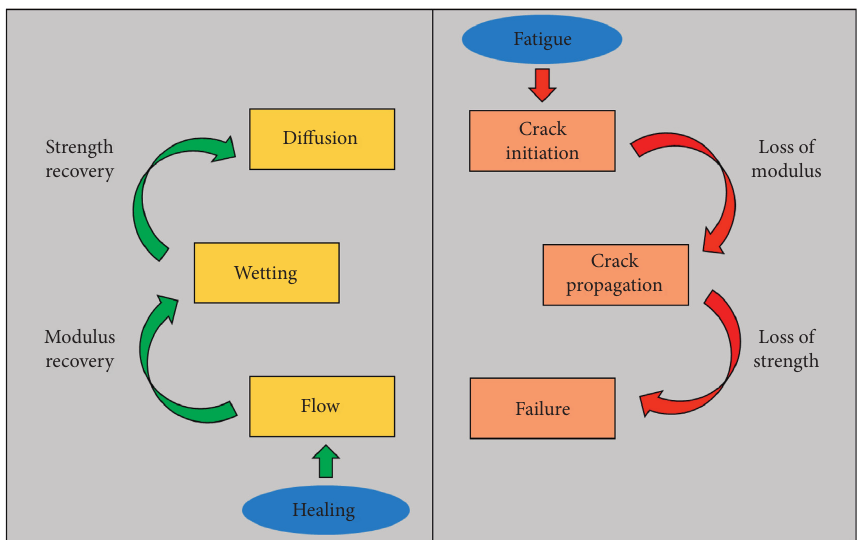
Figure 1: Three-step healing mechanism in asphalt